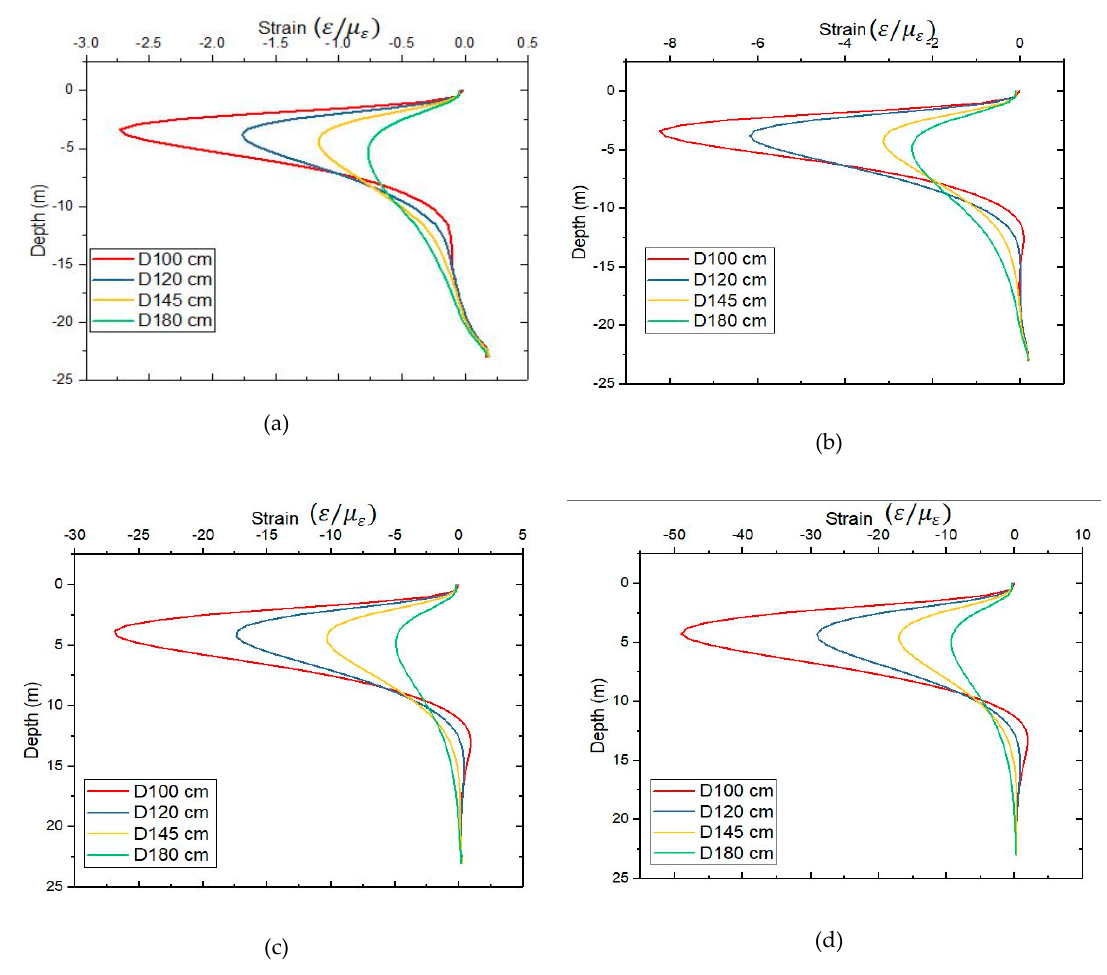
Figure 14. Impact of diameter on the strain distribution along the reinforced concrete pile, ( a ) The strain of the pile in the function of di ff erent diameters at load 110,000 N; ( b ) The strain of the pile in the function of di ff erent diameters at load 440,000 N; ( c ) The strain of the pile in the function di ff erent of diameters at load 1,100,000 N; ( d ) The strain of the pile in the function of di ff erent diameters at load 1,650,000 N.